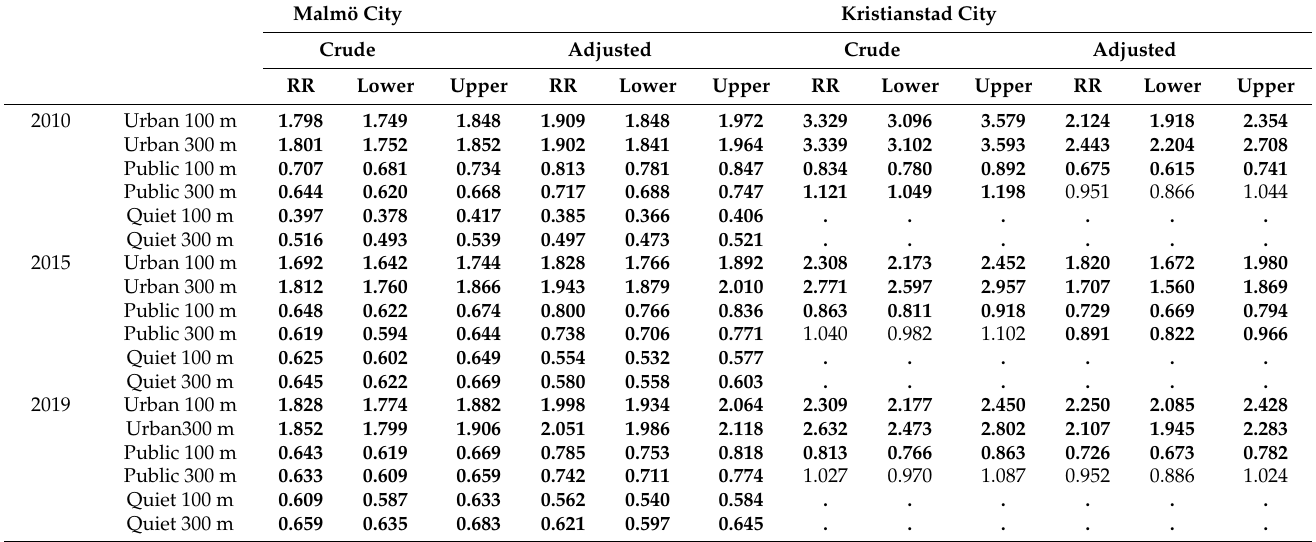
Table A3. Risk ratios for crude and multivariate associations between living in an apartment vs detached single-family house in availability to total urban green space (Urban), publicly available urban green space (Public) and quiet publicly available urban green space (Quiet). RR for 100 m and 300 m buffer distances from the residence for the three different types of urban green spaces are presented. Malmö City Kristianstad City Crude Crude